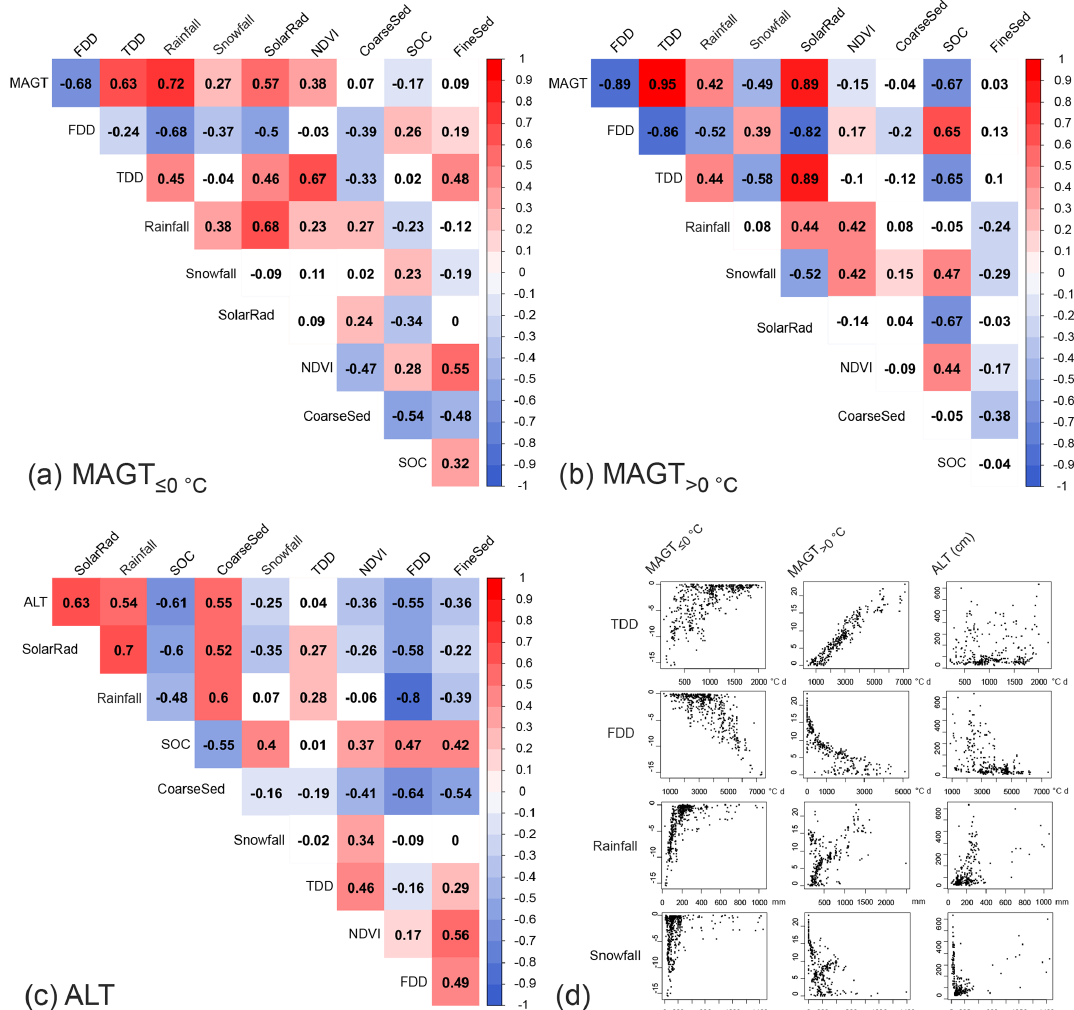
Figure 2. Spearman rank-order correlations between the predictor variables (see Sect. 2.2 for abbreviations) and MAGT ≤ 0 ◦ C (mean annual ground temperature) (a) , MAGT > 0 ◦ C (b) and ALT (active-layer thickness) (c) . Shades of red stand for positive correlations, shades of blue stand for negative correlations, and white indicates non-significant ( p >0.01) correlations. Panel (d) shows MAGT and ALT observations plotted against the climatic